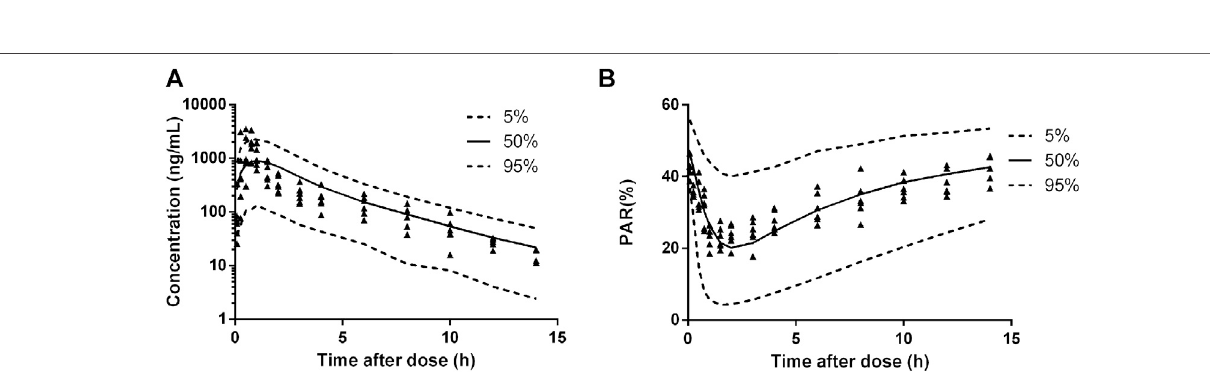
Frontiers in Pharmacology |